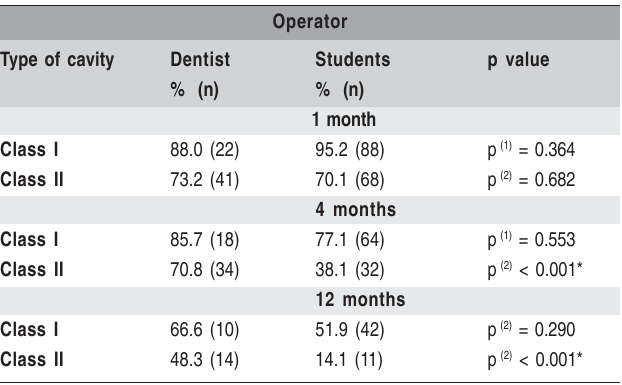
Table 4: Distribution of success rate according to the operator at 1, 4 and 12 months